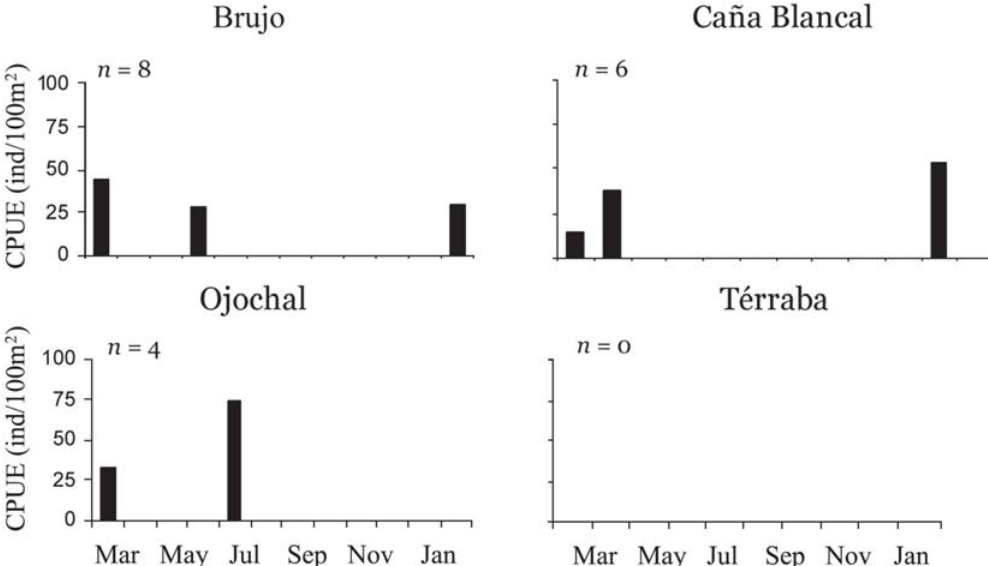
Fig. 3. Capture per unit effort (CPUE) by month for Brycon behreae recruits in the Térraba River and three tributaries.